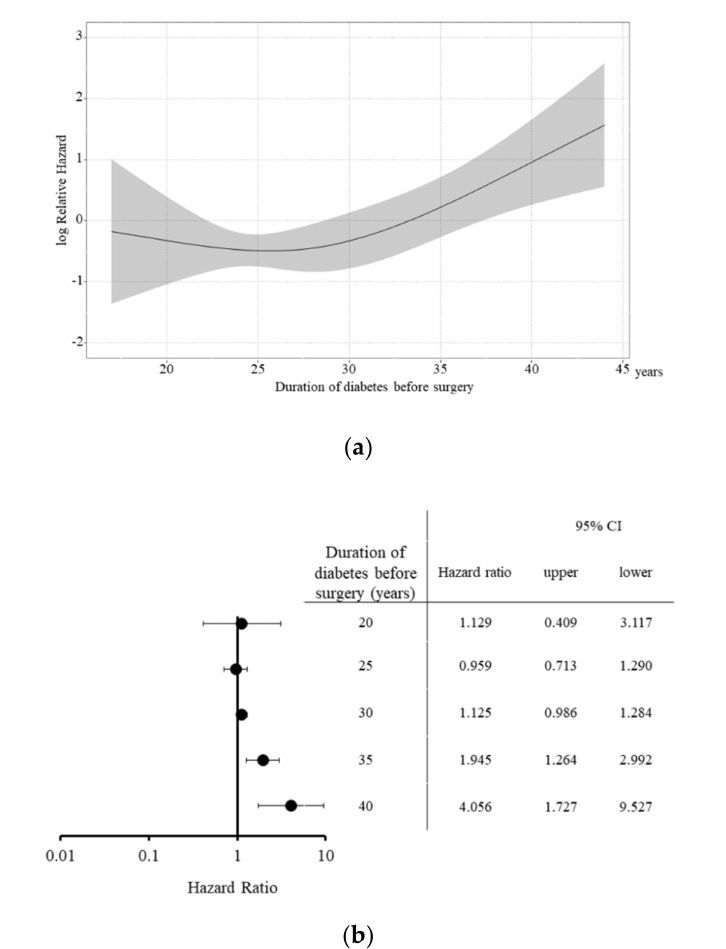
Figure 4. Impact of the duration of diabetes before surgery on patient survival after simultaneous pancreas and kidney transplantation. The predicted log relative hazard according to the duration of diabetes before surgery (determined with a nonlinear model) revealed that ( a ) a < 28-year history of diabetes (the median duration of diabetes) did not significantly increase the Hazard ratio (HR), but a significant increase in the patients with a > 35-year history of diabetes before surgery (HR = 1.945, 95% Confidence interval = 1.264–2.992) and those with a > 40-year history of diabetes before surgery (HR = 4.056, 95% CI = 1.727–9.527), respectively ( b